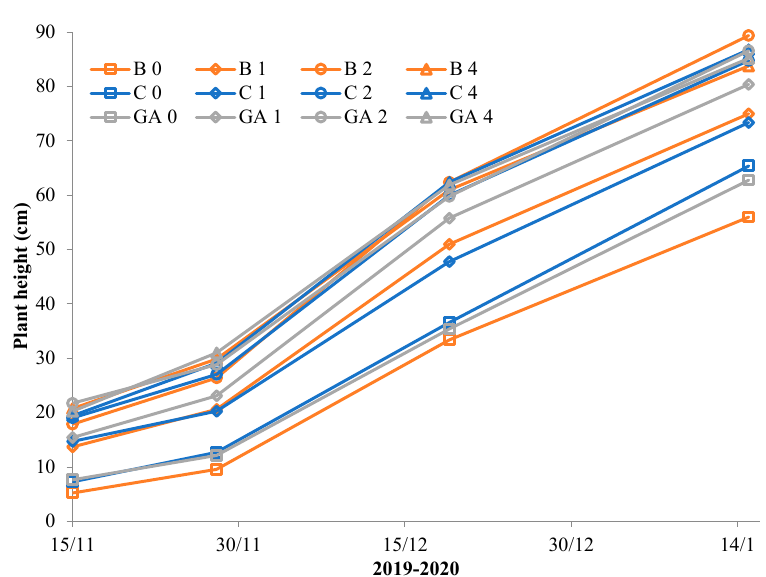
Figure 8. Effect of the seedling treatments (C, untreated control, B, bacterial biostimulant, GA3, gibberellic acid spray 10 − 5 M) and the nursery fertigation rates (0, 1, 2, and 4 g L − 1 of NPK 20 ‐ 20 ‐ 20) on Solanum lycopersicum ‘Marmande’ plant growth. Table 3. E ff ects of the seedling treatments (C, untreated control, B, bacterial biostimulant, GA3, morphological parameters of Solanum lycopersicum ‘Marmande’ plants grown in soilless cultivation. Source of Variance (%)Total Roots Stem Leaves Trusses Total Roots